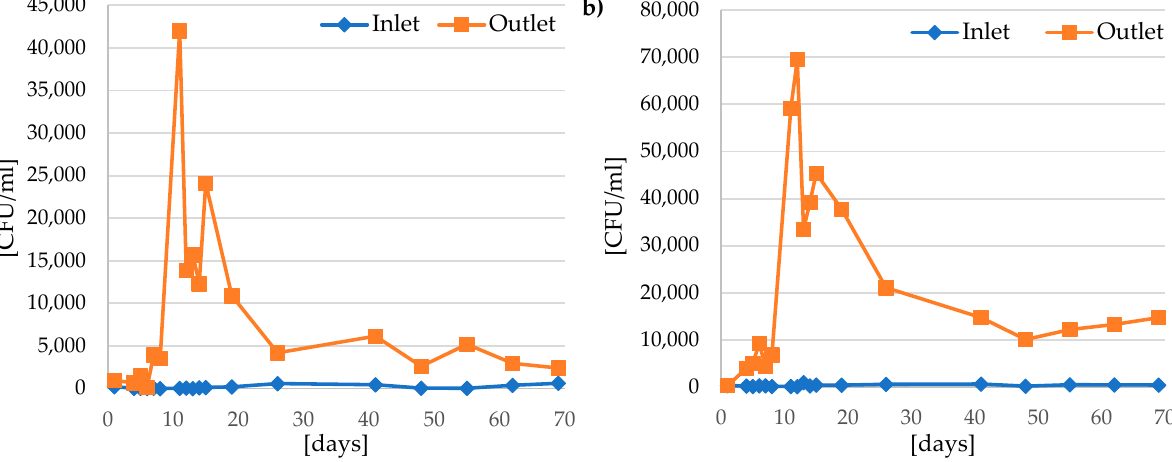
Figure 6. Microbiological quality of water in the inflow and outflow of the system: ( a ) bacteria growing at 37 °C, ( b ) bacteria growing at 22 °C (R2A agar).